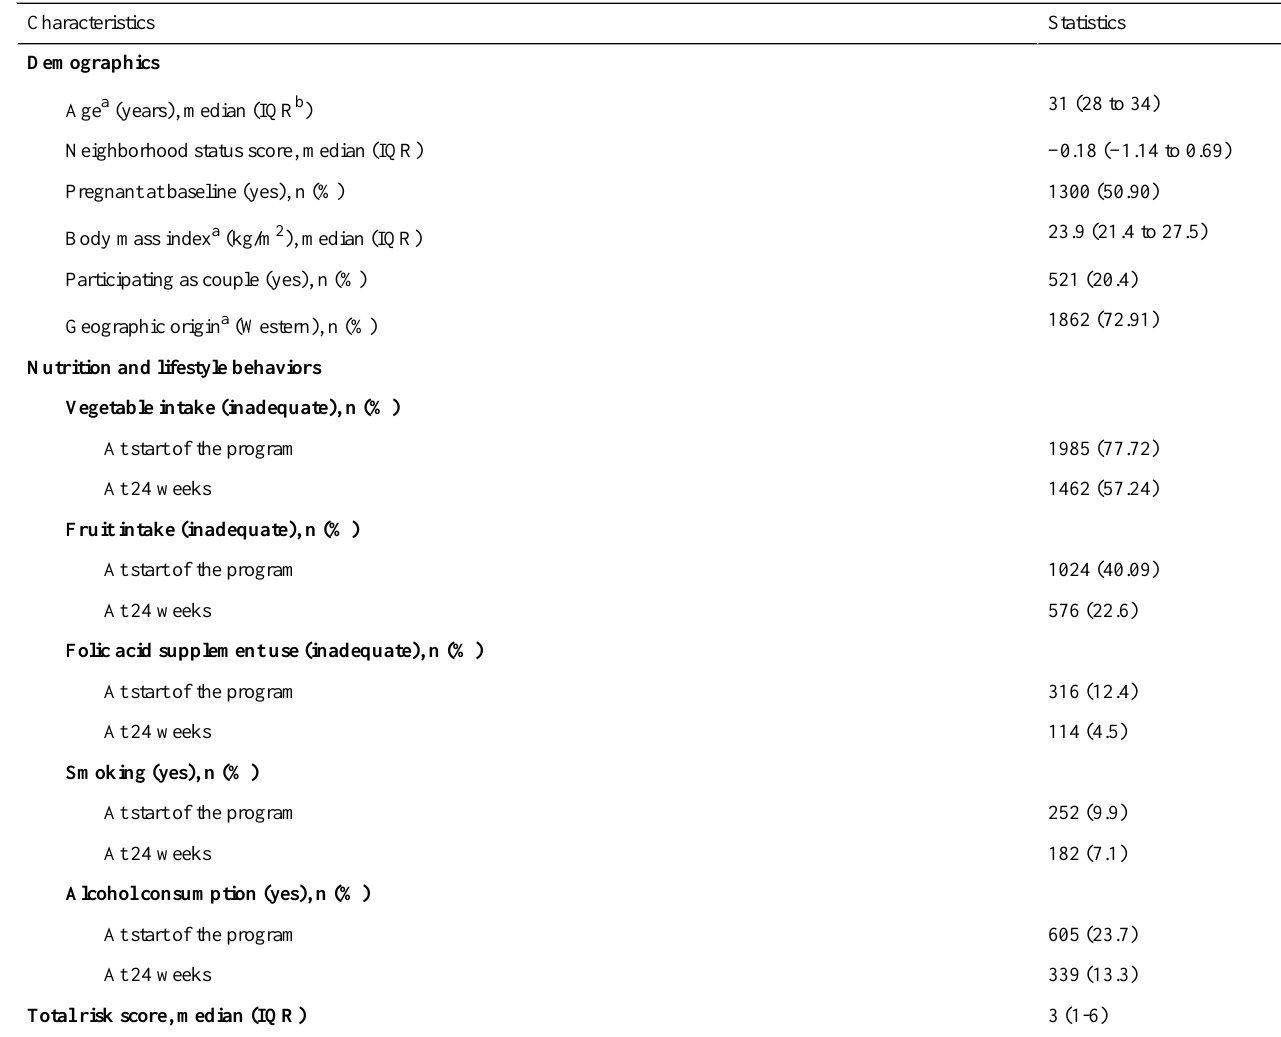
Table 1. Demographics of the study population and nutrition and lifestyle behaviors at the start and after 24-weeks of coaching with the Smarter Pregnancy mobile health coaching program (N=2554).